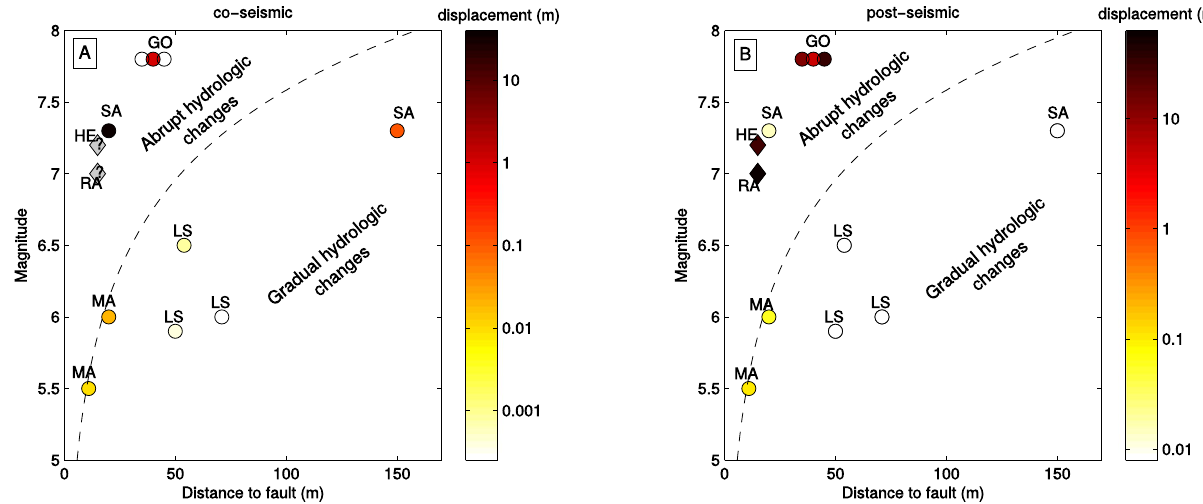
Figure 6. Co- ( A ) and post-seismic ( B ) motions of landslides as a function of the earthquake magnitude and distance to faults, for all the case-studies from the litterature. LS: La Sorbella 10 , MA: Maca 5,11 , SA=Sarpol- Zahab 13 , GO: Gorkha (this study), RA: Racha 4 , HE: Hebgen Lake 12 . The main characteristics of these landslides are exposed in Table S2. The circles denote case-studies with physical measurements of the displacement, whereas diamonds denote the case-studies where only visual testimonies were available. For these latter cases, the co-seismic motion is uncertain and noted with a gray color. The dashed black line represents the limit defined by 18 to differentiate the abrupt and gradual co-seismic hydrological responses of water-level in